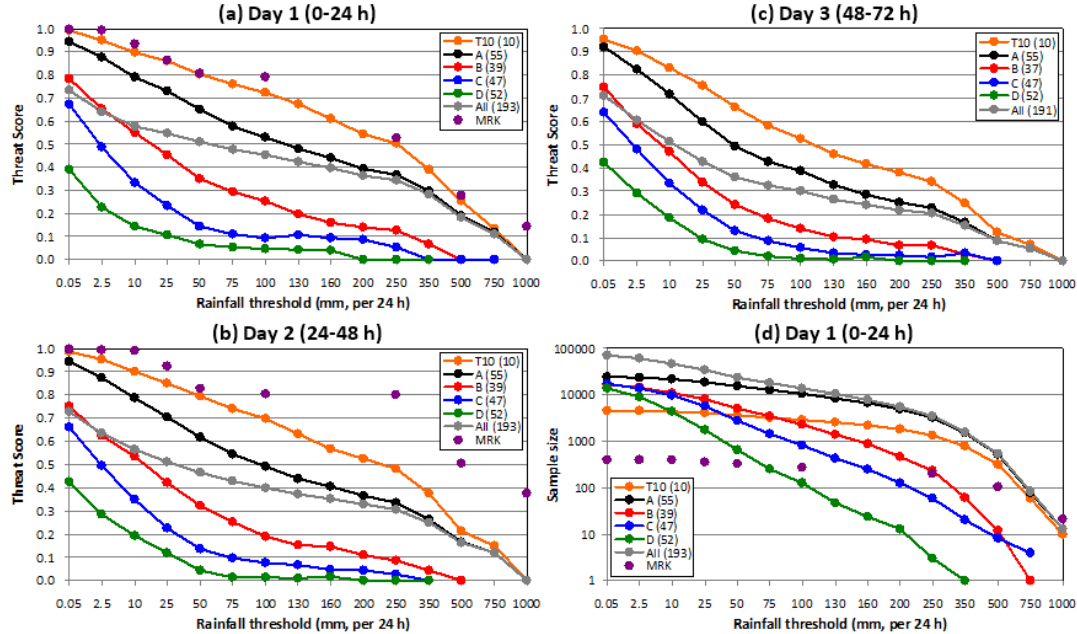
Figure 6. The TS of 24 h QPFs for ( a ) day 1 (0–24 h), ( b ) day 2 (24–48 h), and ( c ) day 3 (48–72 h) by the CReSS model for 29 typhoons from 2010–2015 in Taiwan as a function of rainfall threshold (mm) for group T10, groups A to D, and all segments. For each group at a threshold, a single 2 × 2 contingency table was used. The scores of single forecasts for TY Morakot in 2009 (MRK, target period: 12:00 a.m.–12:00 p.m. UTC 8 Aug 2009, days 1–2 only) are also plotted. ( d ) Total numbers of verification points involved to compute the TS ( H + M + FA ) in day 1 QPFs for the various groups and MRK across the thresholds (in logarithmic scale).